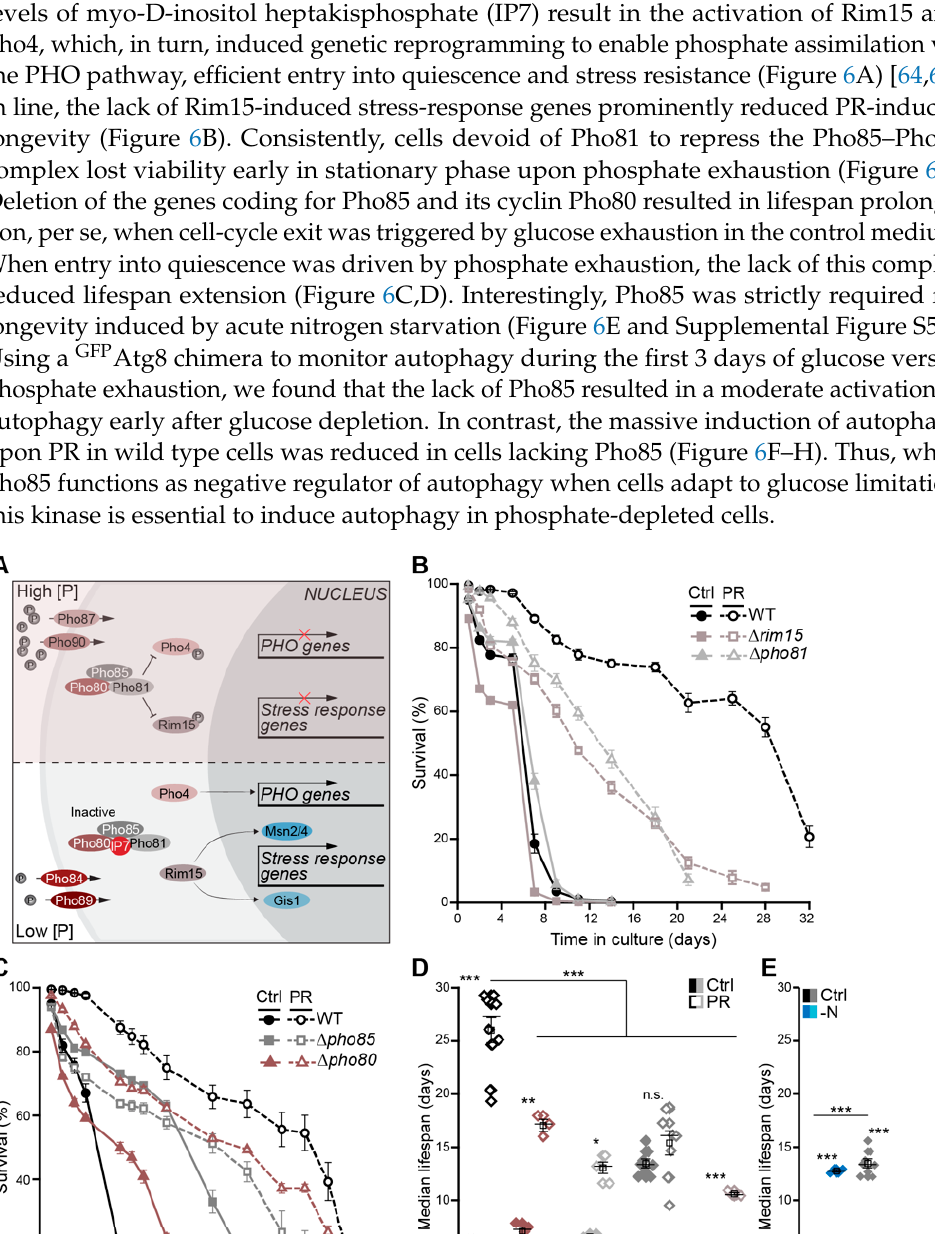
Figure 6. The cyclin-dependent kinase Pho85 is critical for phosphate exhaustion-induced autoph- agy. ( A ) Schematic representation of the yeast phosphate signaling (PHO) pathway. ( B–D ) Survival during chronological aging, determined via flow cytometric quantification of PI staining, of WT, ∆ rim15 and ∆ pho81 cells ( B ), and of WT, ∆ pho80 and ∆ pho85 cells ( C ) grown on Ctrl or PR media; n = 4. Corresponding median lifespan is shown in ( D ). ( E ) Median lifespan of WT and ∆ pho85 cells grown on Ctrl or nitrogen starvation (-N) medium; n = 4. ( F ) Confocal micrographs of WT and ∆ pho85 cells harboring GFP Atg8 and Vph1 RedStar (as vacuolar marker) at day 3 of aging on Ctrl or PR media. Scale bar represents 3 μ m. ( G , H ) Representative immunoblot ( G ) and corresponding densi- tometric quantification ( H ) of protein extracts from WT and ∆ pho85 cells harboring endogenously GFP-tagged Atg8 grown on Ctrl or PR medium. Blots were decorated with an antibody against GFP, and the ratio free GFP/ GFP Atg8 was plotted; n = 8. For statistical analysis, Welch–ANOVA with Dun- nett T3 post hoc test ( D ) or a two-way ANOVA ( H ) was used. * p < 0.05, ** p < 0.01 and *** p < 0.001.